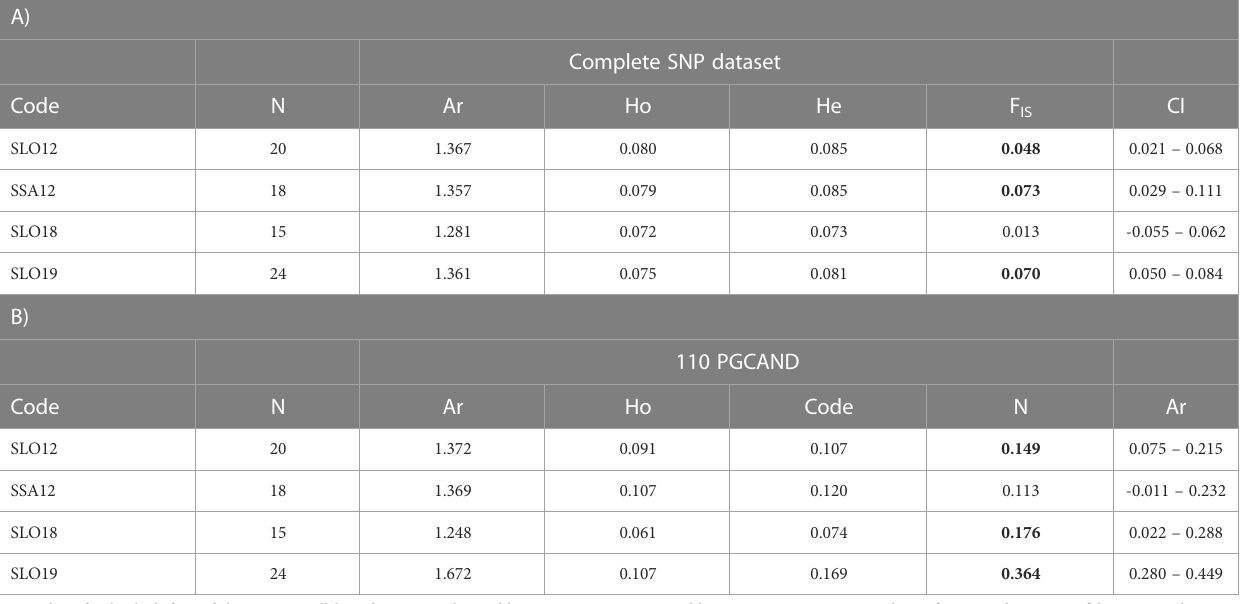
TABLE 4 Genetic diversity in Cerastoderma edule samples from R ı ́ a de Arousa with: A) Whole dataset (9154 SNPs); B)110 PGCAND dataset.